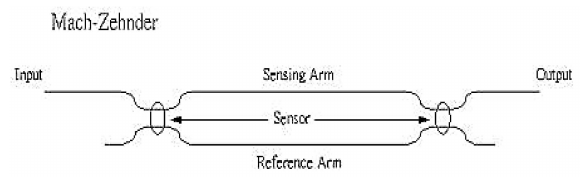
Figure 2. Mach-Zehnder